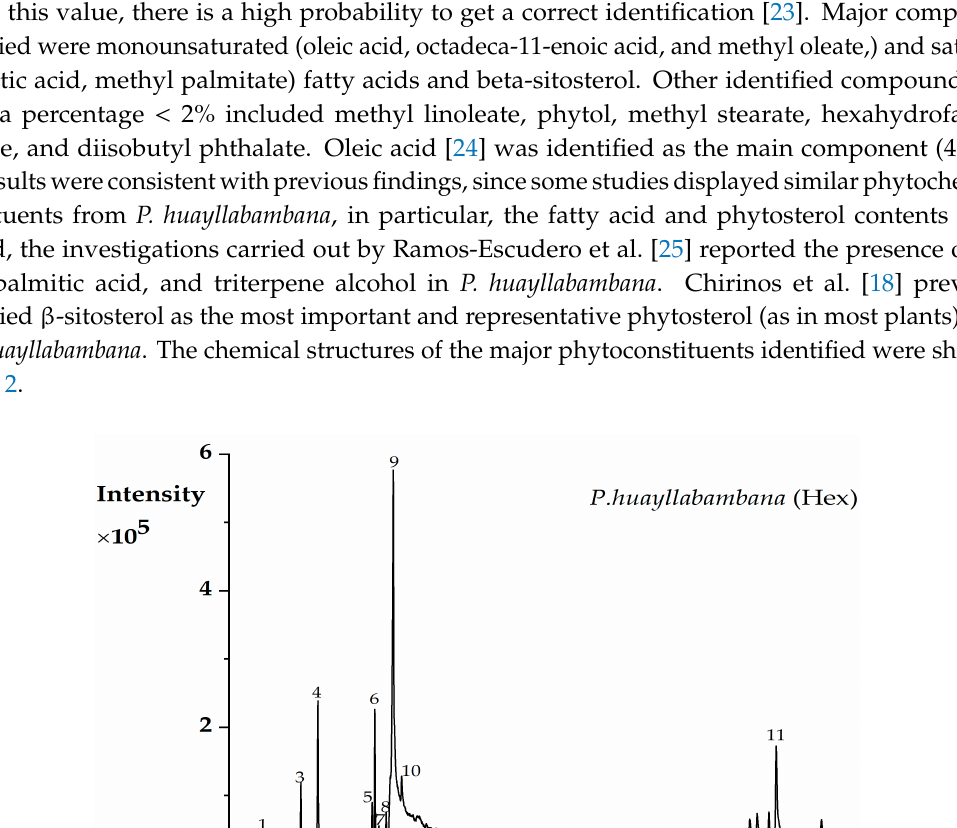
Table 1 . Identified components from the n-hexane fraction of P. huayllabambana by gas chromatography–mass spectrometry (GC–MS) analysis.